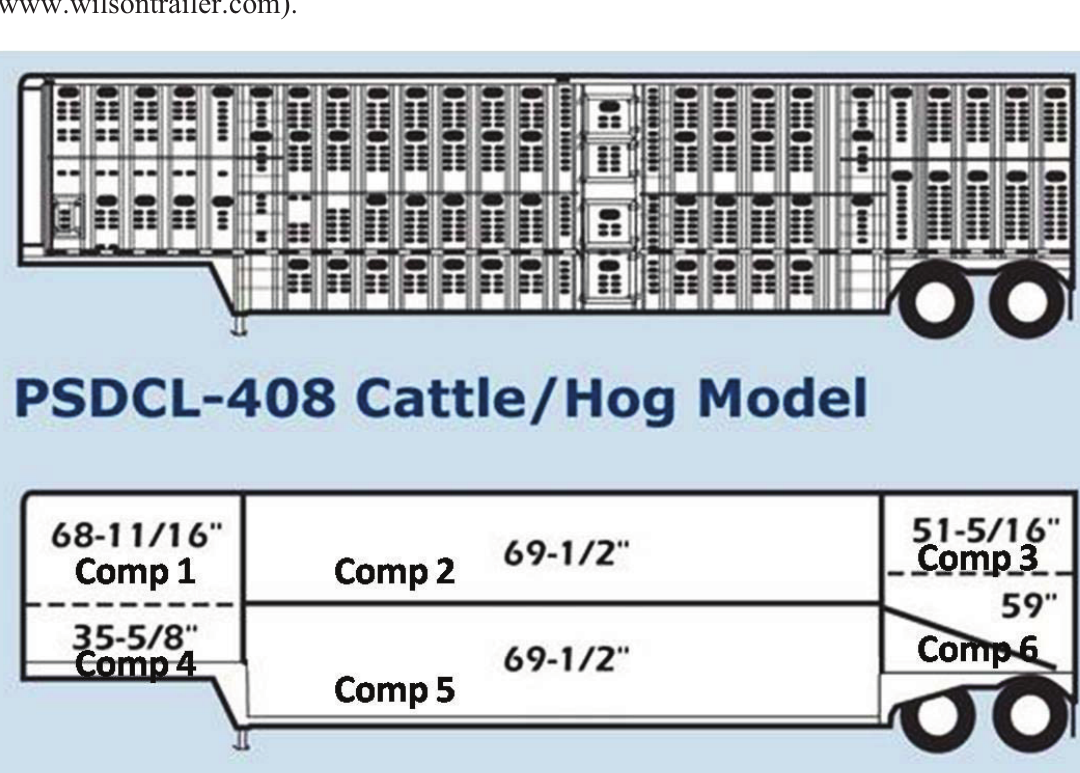
1. Experimental trailer design and compartment location within trailer